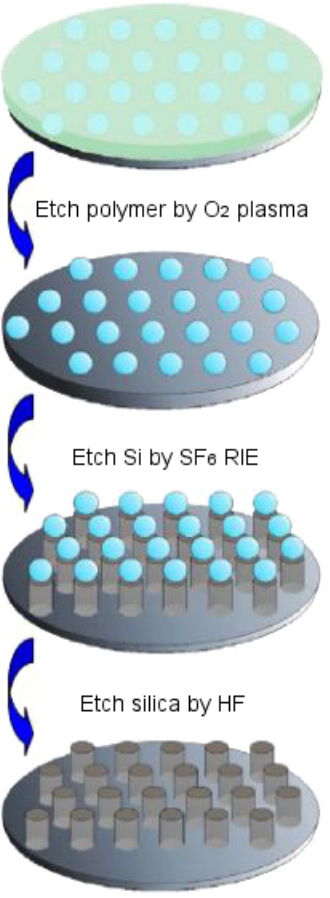
Figure 14. Schematic diagram for fabricating moth eye-like conical protuberances on silicon substrate using the templating technique for anti-reflection properties. Reproduced from [66] with the permission of AIP Publishing. RIE: Reactive ion